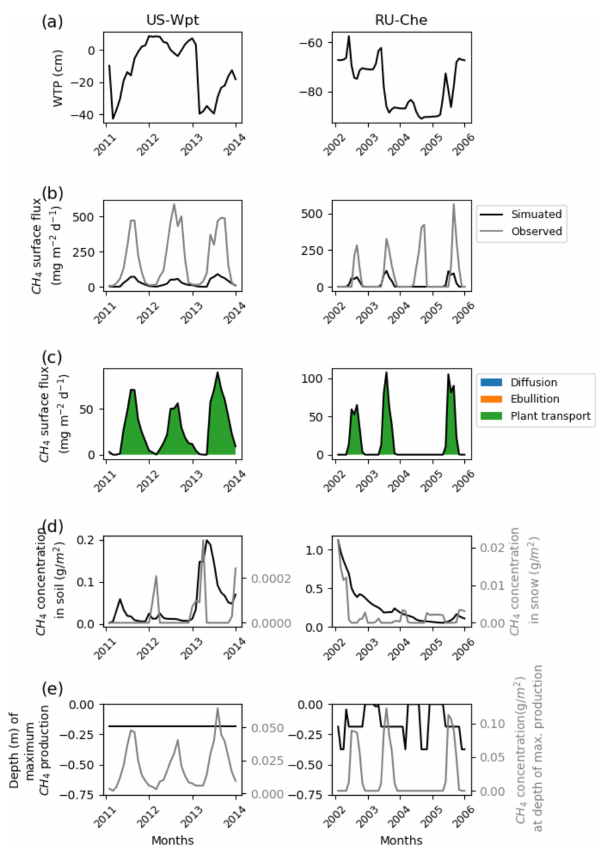
Figure 5. Temporal distribution of methane for sites emitting more than 400mgCH 4 m − 2 d − 1 . (a) Simulated water table position es- timated from the soil water content. (b) Simulated (dark line) and observed (gray line) methane emissions released to the atmosphere. (c) Cumulative amount of simulated methane emitted by diffusion, plant-mediated transport, and ebullition. (d) Methane concentration in the soil layers (dark line) and in the snow layers (gray line) of the model. (e) On the left is the depth at which simulated methane production is the highest in the soil, scaled to the maximum peat depth. On the right is the amount of simulated methane produced at these